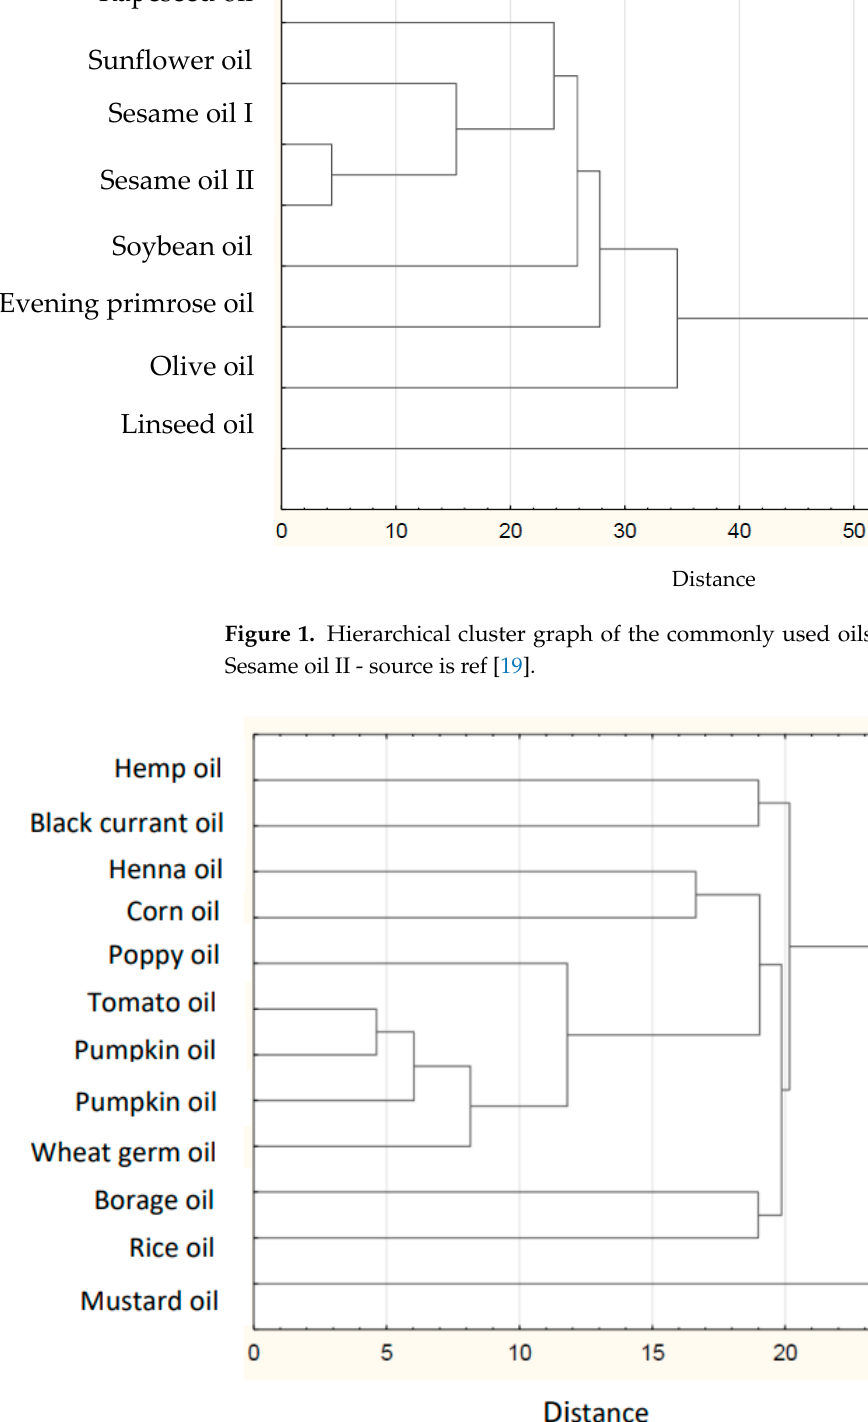
Figure 2. Hierarchical cluster graph of unconventional oils.